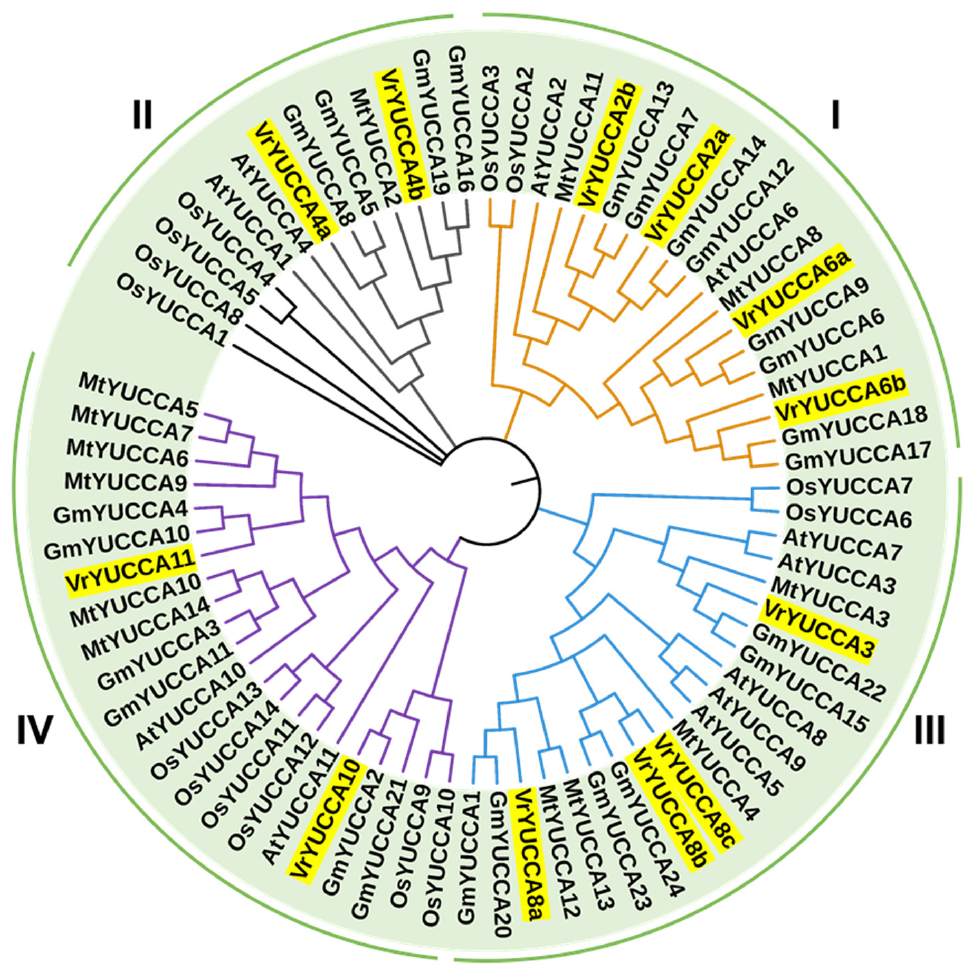
Figure 2. Phylogenetic tree of 75 YUCCA proteins from mungbean, Arabidopsis , soybean, rice, and Medicago. Vr, Vigna radiata ; At, Arabidopsis thaliana ; Gm, Glycine max ; Os, Oryza sativa ; Mt, Medicago truncatula . Each color represents a branch, and 12 VrYUCCAs are highlighted.